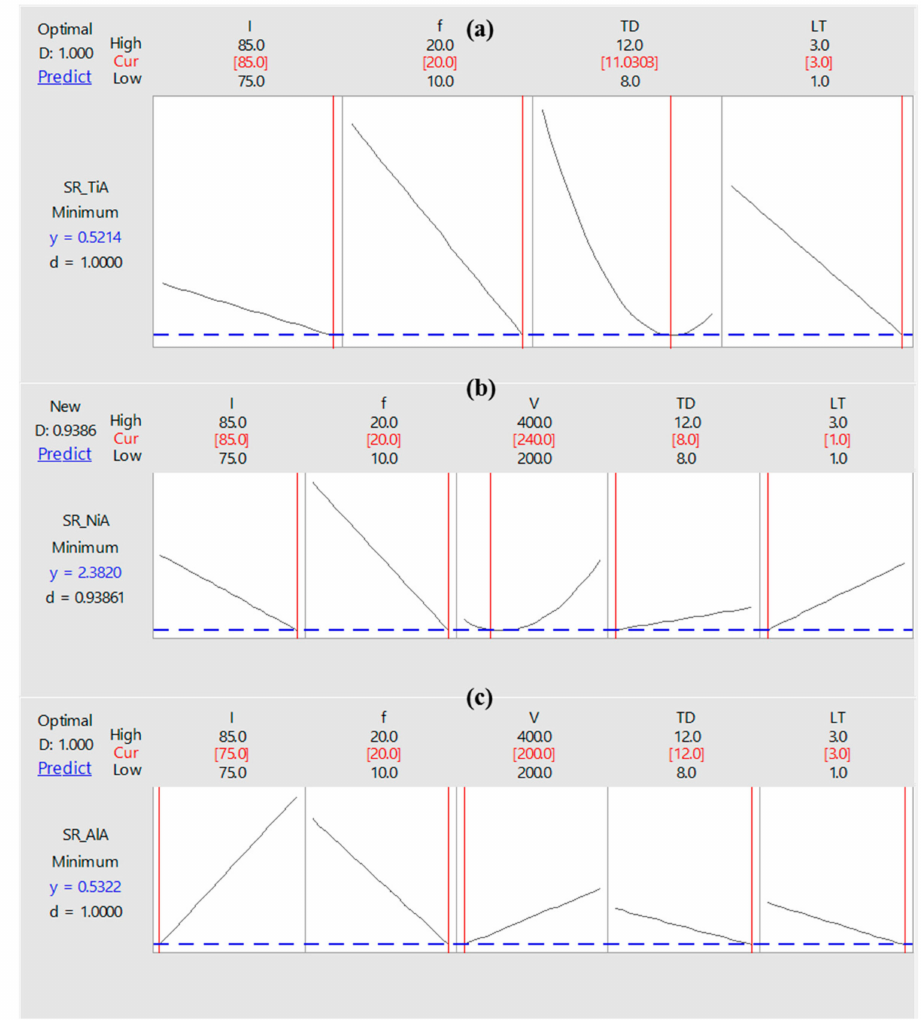
Figure 10. Optimization plot for surface roughness in: ( a ) TiA, ( b ) NiA, and ( c ) AlA.